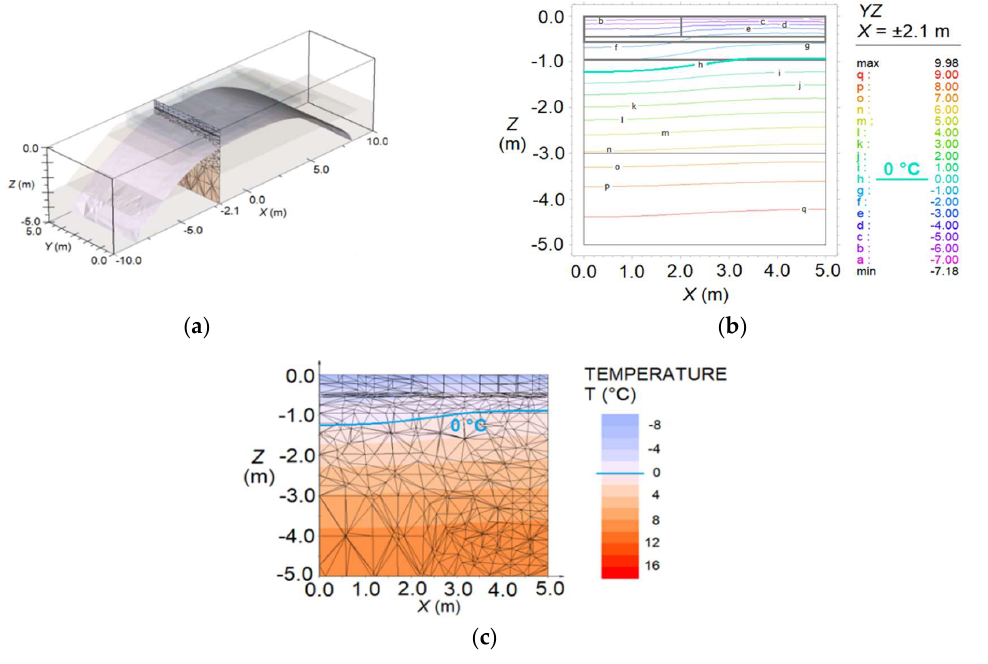
Figure 5. Graphic outputs X = 2.1 m: ( a ) 3D view; ( b ) isotherms; ( b ) cross-section.